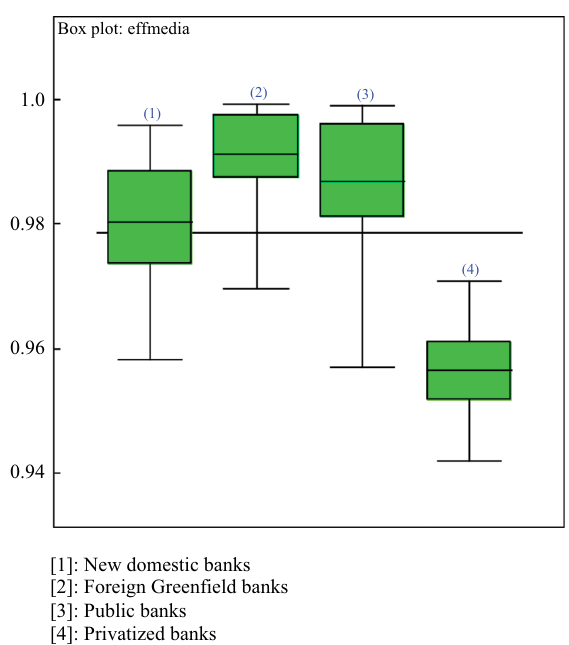
Fig. 1. Boxplot of the posterior distribution of the mean cost bank efficiency classified according to its type of ownership without distinguishing presence/ absence of a foreign strategic owner and using the exponential model